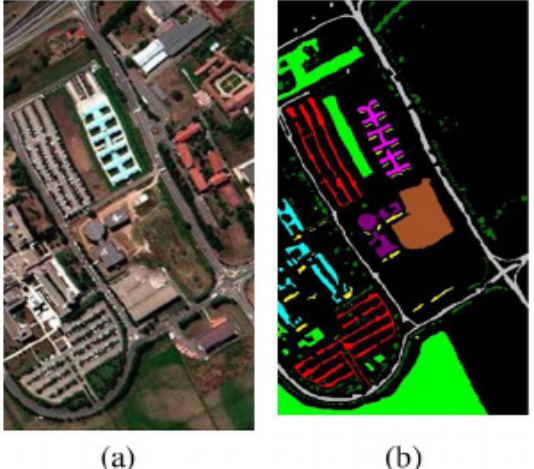
Figure 11. Detection of Areas in Pavia Dataset: ( a ) Segmented Image; ( b ) Detection. Below in Figure 12 is a screenshot of the Salinas image dataset’s CNN model being used to detect and classify portions.